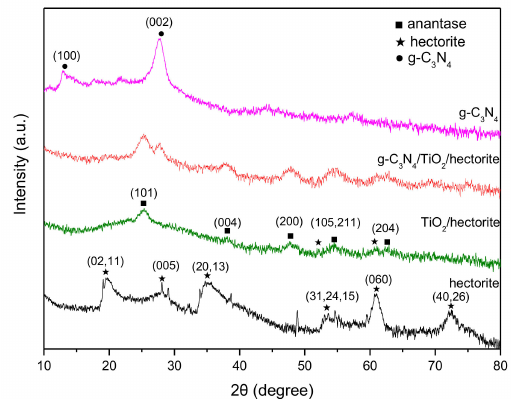
Figure 1. X-ray diffraction (XRD) patterns for hectorite, TiO 2 / hectorite, g-C 3 N 4 / TiO 2 / hectorite and g-C 3 N 4